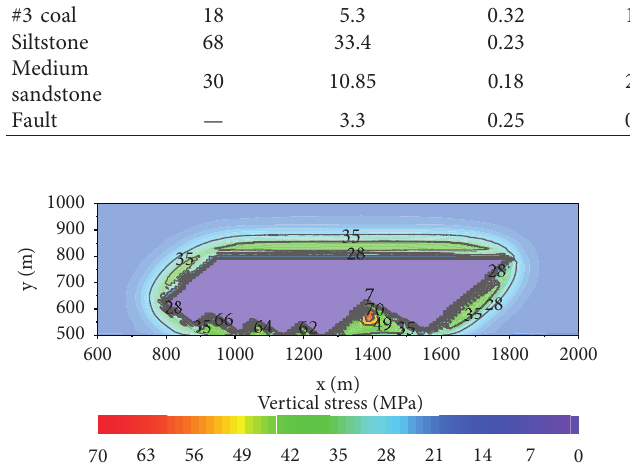
Figure 4: The vertical stress distribution of